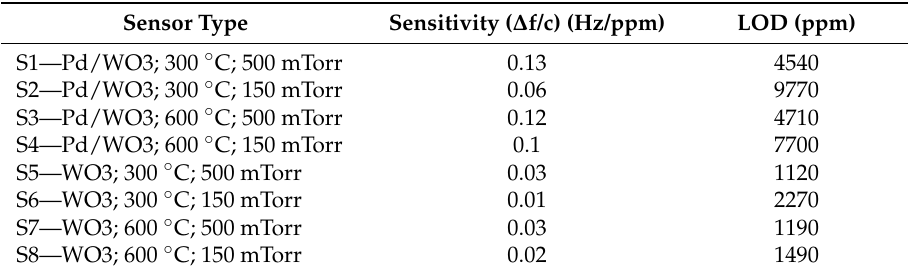
Table 2. Sensitivity and limit of detection ( ∆ f-frequency change, c–hydrogen gas concentration) for the various sensitive